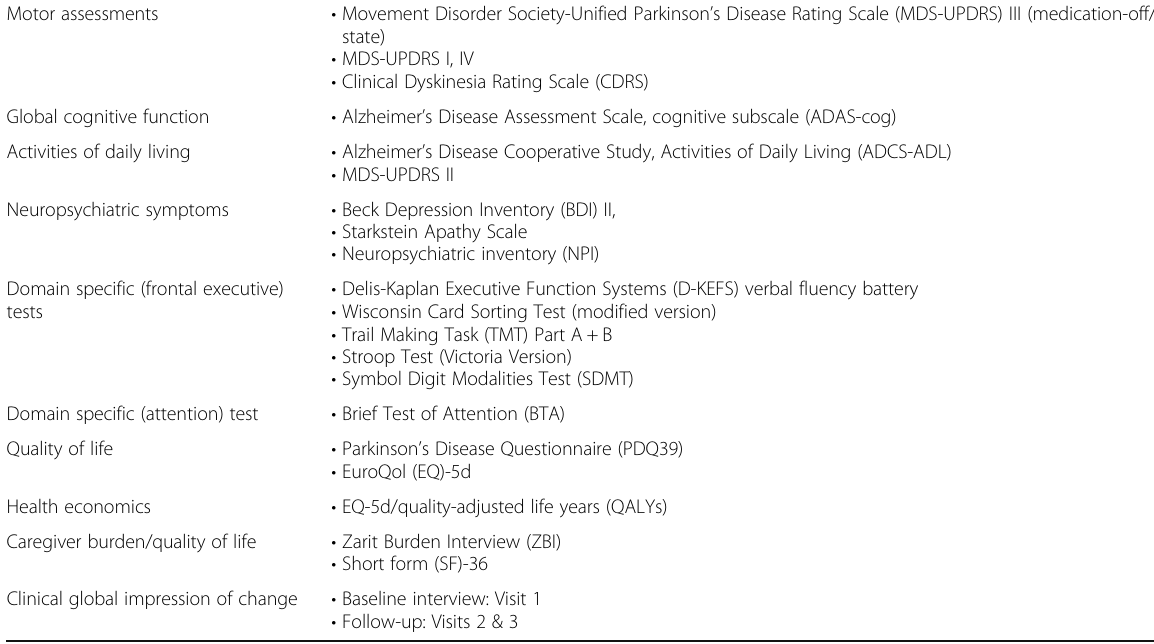
Table 2 Data set: assessment at presurgical/postsurgical baseline, visits 1 – 3 Motor